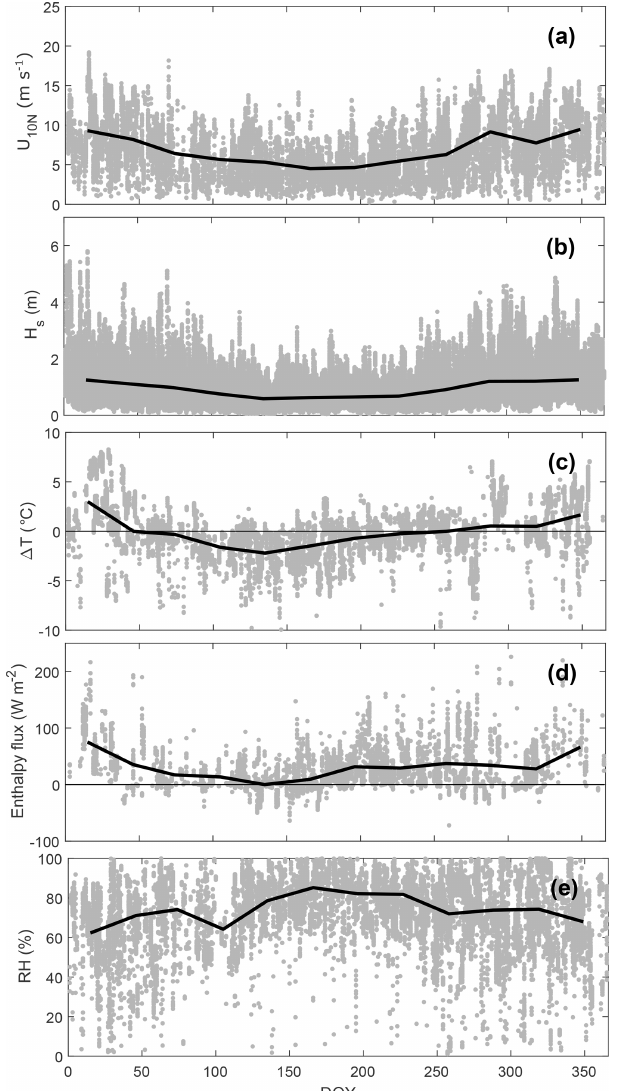
Figure 4. Annual cycle of (a) 10m neutral wind speed, (b) signifi- cant wave height, (c) temperature gradient ( (cid:49)T = T w − T a ), (d) en- thalpy flux, and (e) relative humidity. The dots are the half-hourly values, and the solid black lines represent the monthly average of each parameter.